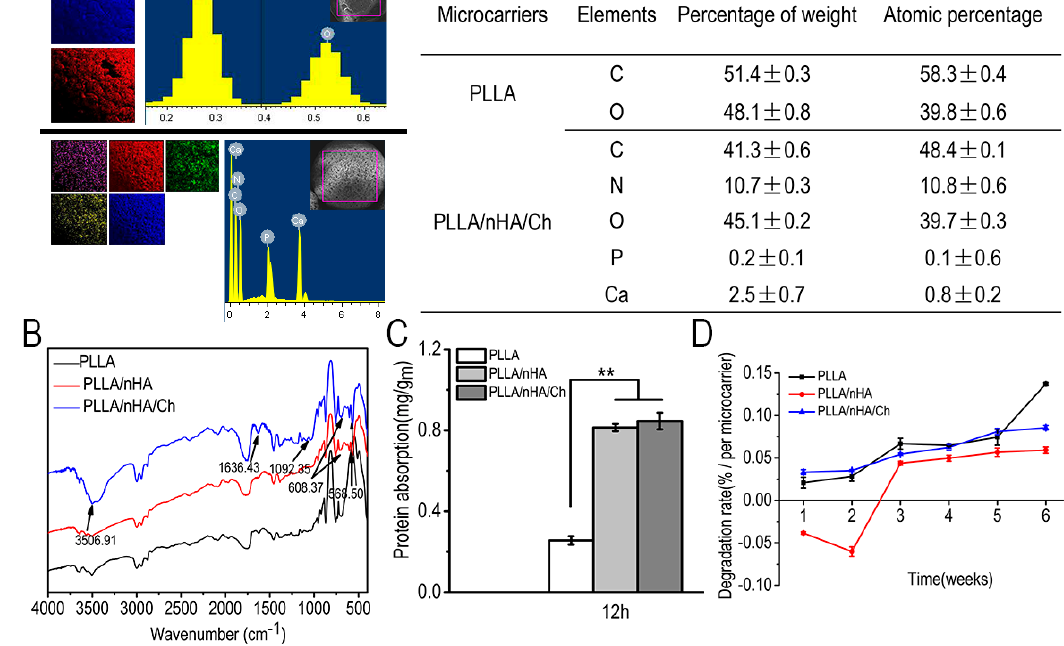
Figure 4. ( A ): Semi-quantitative analysis of surface elements of PLLA microcarriers (including carbon and oxygen) and PLLA/nHA/Ch microcarriers (including carbon, nitrogen, calcium, phosphorus, and oxygen); ( B ): Analyses of characteristic chemical functional groups of the three kinds of microcarriers by Fourier transform infrared spectroscopy; ( C ): Amount of protein adsorbed on the surfaces of microcarriers after incubation for 12 h at 37 °C. Data were expressed as mean ± SD ( n = 6, ** p < 0.01); ( D ): The degradation of the three kinds of microcarriers in PBS solution.